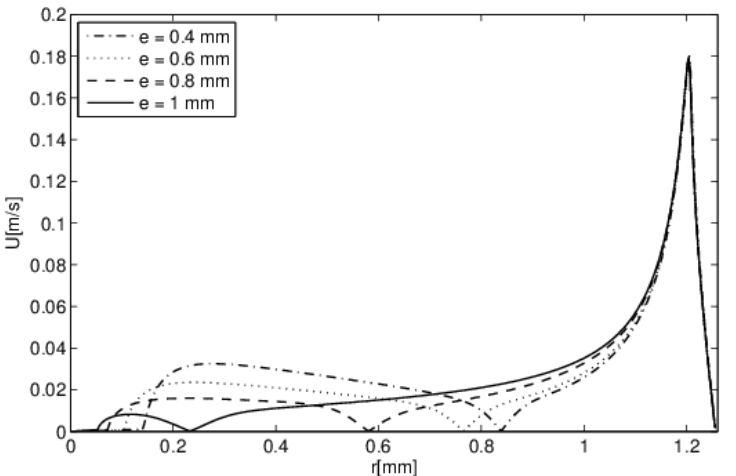
Figure 15. TBH configuration: streamlines and flow direction on PTFE substrate. Influence of the substrate thickness (t = 1 s, θ = 90 ◦ , V 0 = 1 mm 3 , T h = 50 ◦ C, Φ = 3 mW).